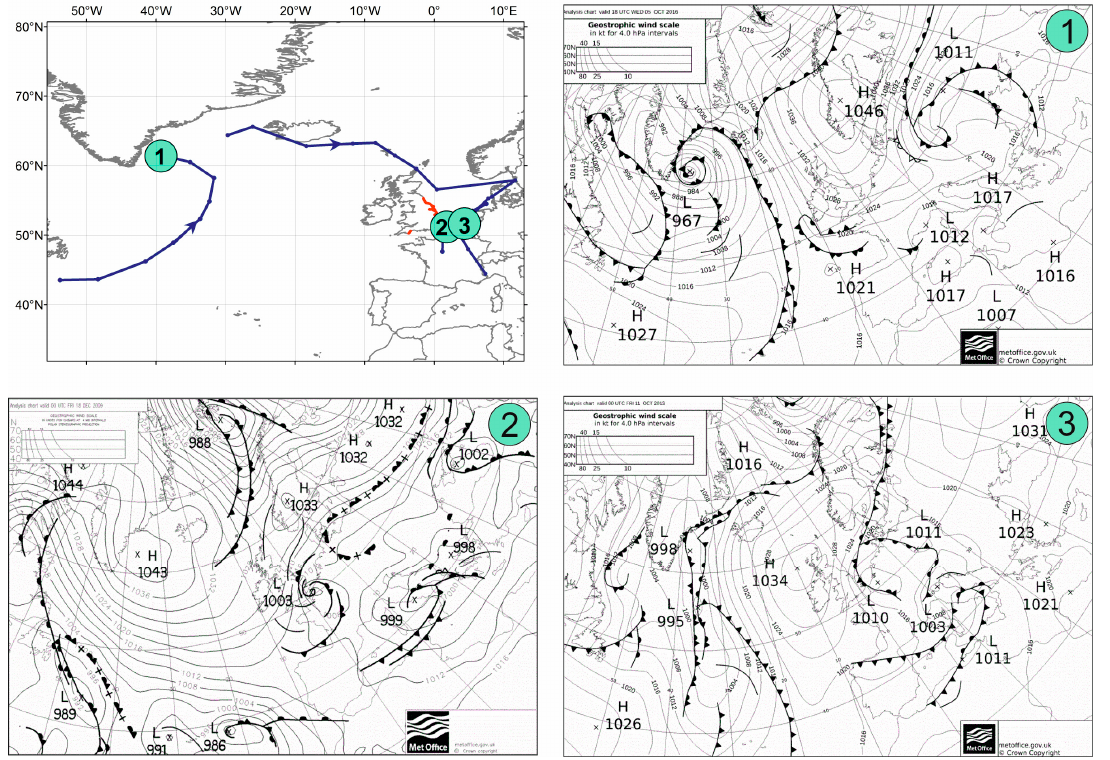
Figure 7. Tracks of storms caused by large pressure gradients between a high-pressure system to the north and a shallow area of lower pressure further south.